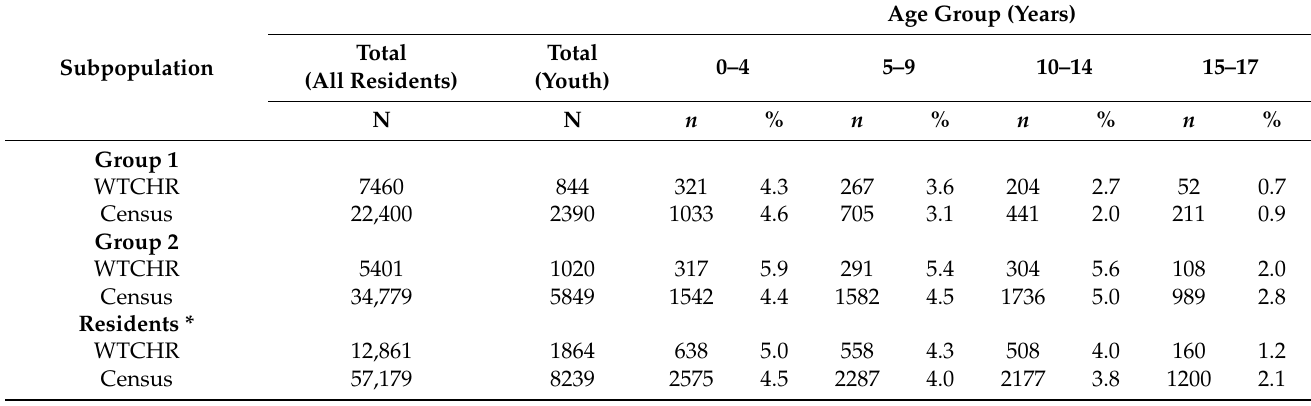
Table 2. Comparison of proportions by age group of WTCHR resident children < 18 years on 11 September 2001 with 2000 census for south of Canal Street in Lower Manhattan. Denominator of proportions is Total for all residents.